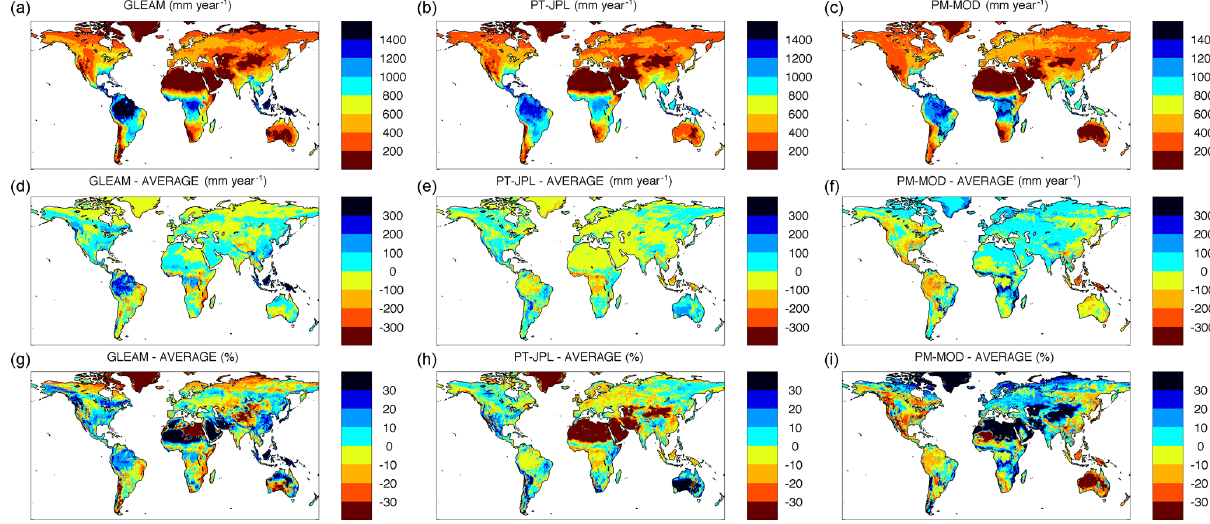
Figure 2. Summary of GLEAM, PT-JPL, and PM-MOD annual ET differences. (a) – (c) : The GLEAM (a) , PT-JPL (b) , and PM-MOD (c) total annual ET in millimetres per year (mmyr − 1 ). (d) – (f) Differences between each product and the simple inter-product mean, in millimetres per year (mmyr − 1 ). (g) – (i) Same differences, but normalized by the inter-product mean ET, and expressed as a percentage.